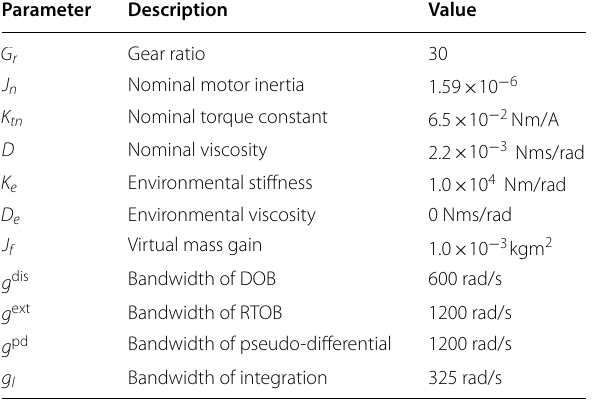
Table 1 Parameters used in the analysis Parameter